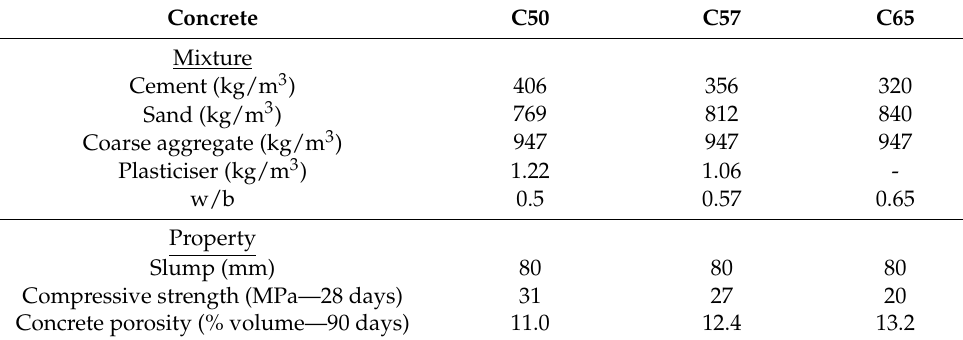
Table 3. Concrete mixtures and